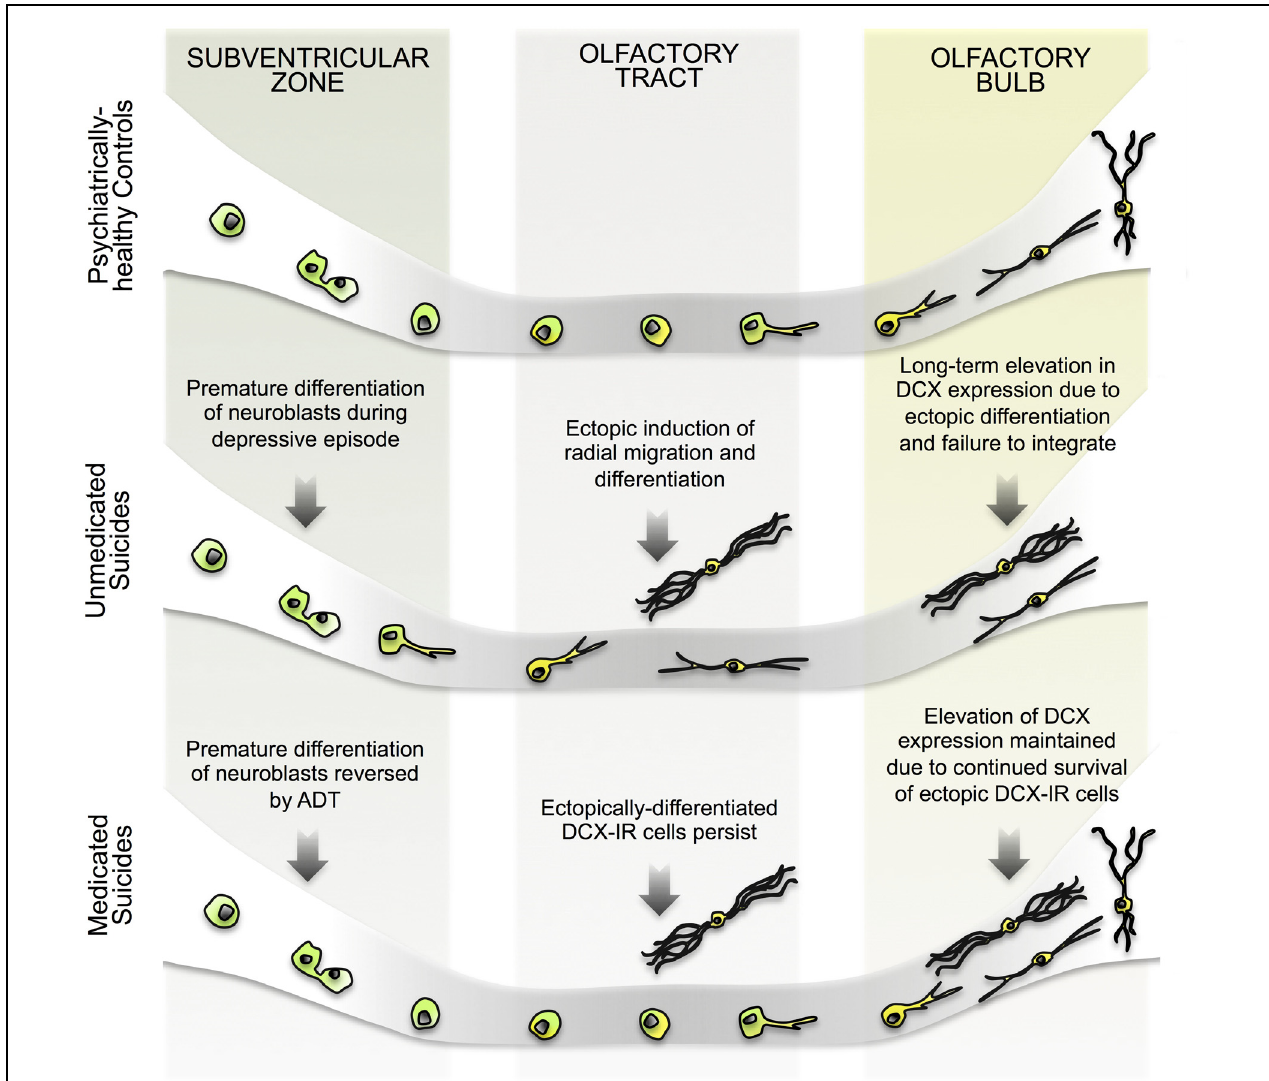
FIGURE 6 | Hypothetical model of changes in human SVZ and OB neurogenesis during depressive episodes. (Top) In psychiatrically healthy subjects, Sox2-expressing progenitors in the SVZ proliferate to give rise to migratory neuroblasts which then migrate toward the OT. During tangential migration, neuroblasts begin the process of differentiation, perhaps extending a leading process, but retain an immature phenotype until they have reached the OB. Having reached the OB, neuroblasts migrate radially toward the granule cell layer and complete their differentiation, integrating into existing neuronal circuits. (Middle) In unmedicated suicides, DCX expression in the SVZ is elevated in the absence of any increase in proliferation due to the premature differentiation of neuroblasts. At this point of development, cells may co-express Sox2 and DCX, as previously reported (Ferri et al., 2004). This early differentiation of neuroblasts in turn impairs migration, and ectopically differentiating cells become trapped at